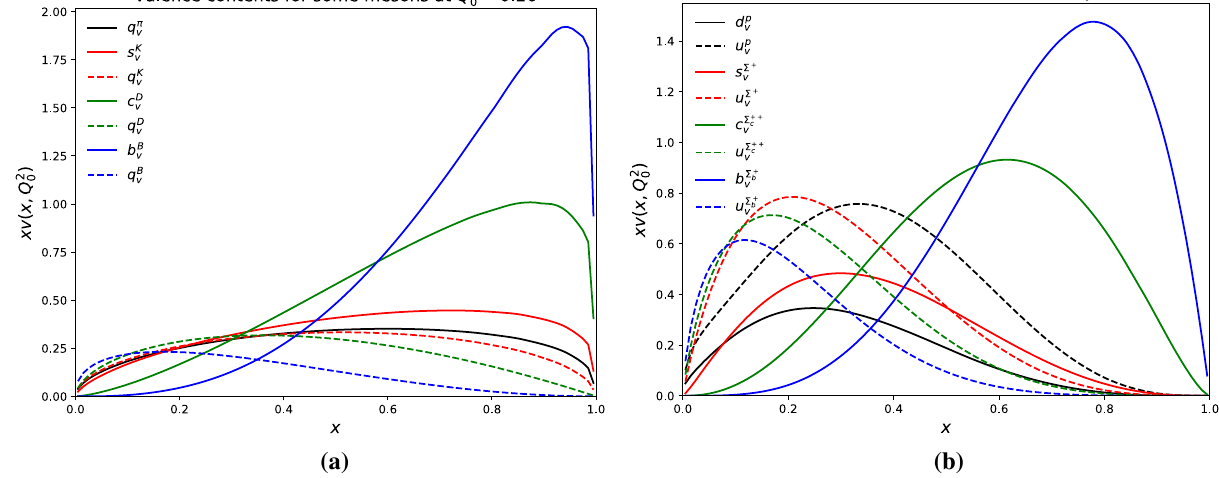
= 0 . 26 GeV 2 , for (a) π , K, D and B mesons, showing the flavoured valence and the q ( = d / u) 0 b